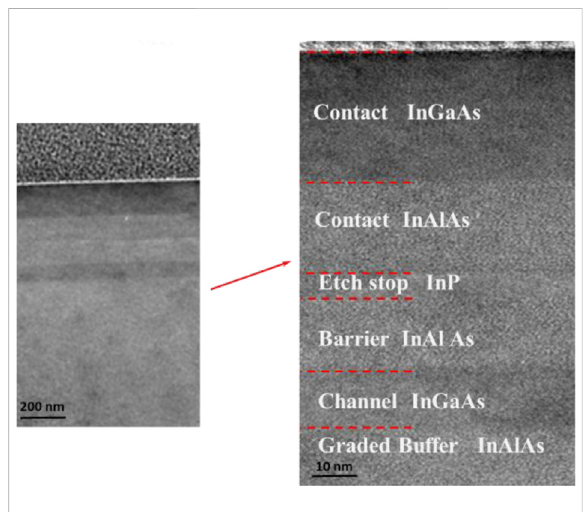
FIGURE 9 The TEMimage of In 0.66 Ga 0.34 As channel PHEMT with 50 nm In x Al 1-x As graded buffer